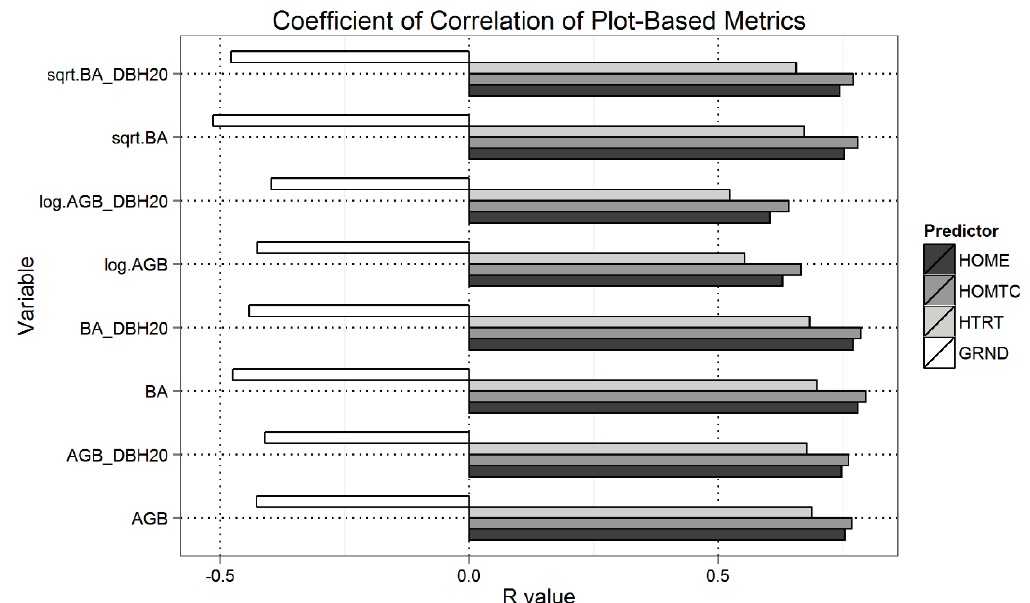
Figure 6. Correlation plot between variables and plot-based predictors derived from large footprint